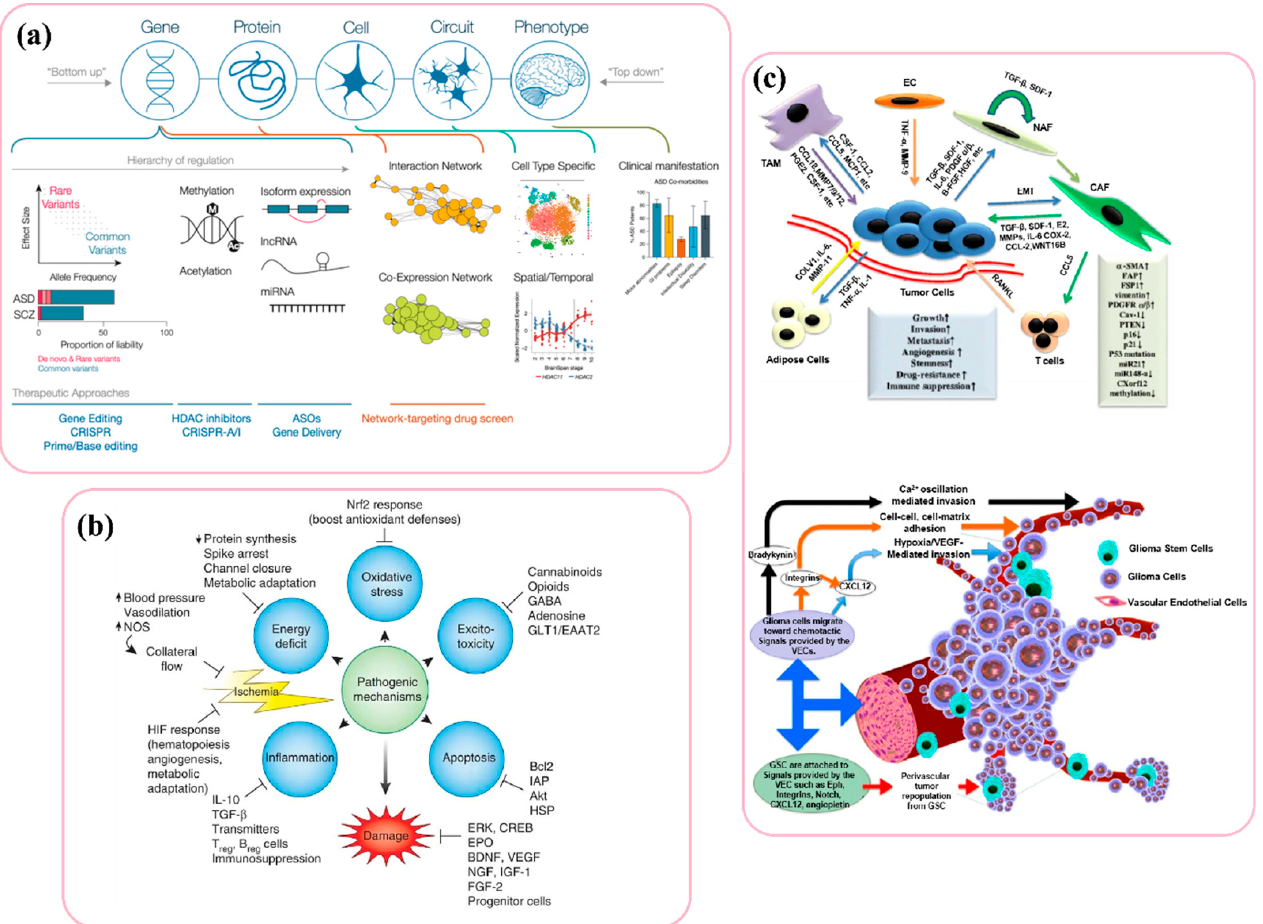
Figure 6. ( a ) Organizational framework for NDD pathogenesis and levels of analysis (adapted with permission from [172] Elsevier, 2022) ( b ) Protective pathways activated by cerebral ischemia, brain stroke (adapted with permission from [173] Springer Nature, 2011) ( c ) Mechanism of interaction of tumor cells with stromal cells in tumor microenvironment promoting tumor growth, invasion, and metastasis (adapted with permission from [174] Springer, 2020).